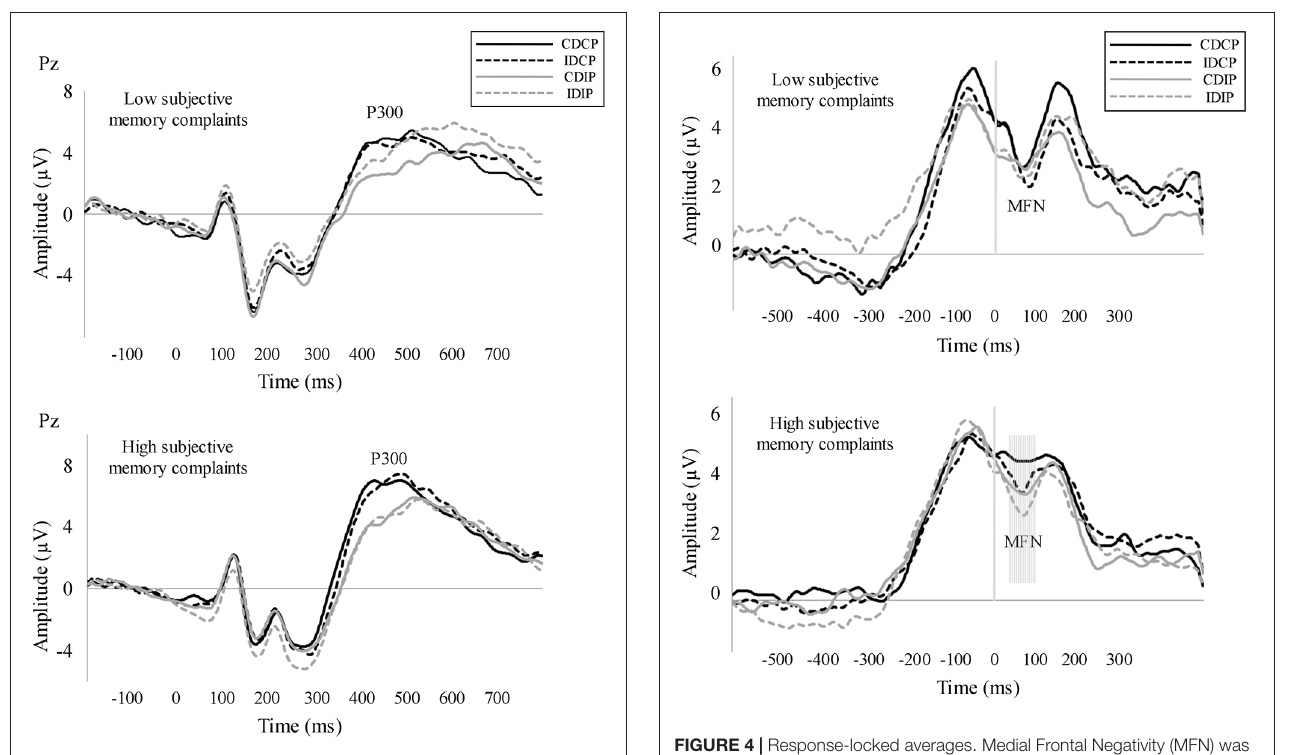
FIGURE 3 | Stimulus-locked averages. P300 was measured as the maximum positive peak observed between 300 ms and 600 ms for each participant and its amplitude in a time window of 100 ms around peak latency. P300 latency was longer and P300 amplitude was smaller in those conditions where the target stimulus position was incompatible with the required response.